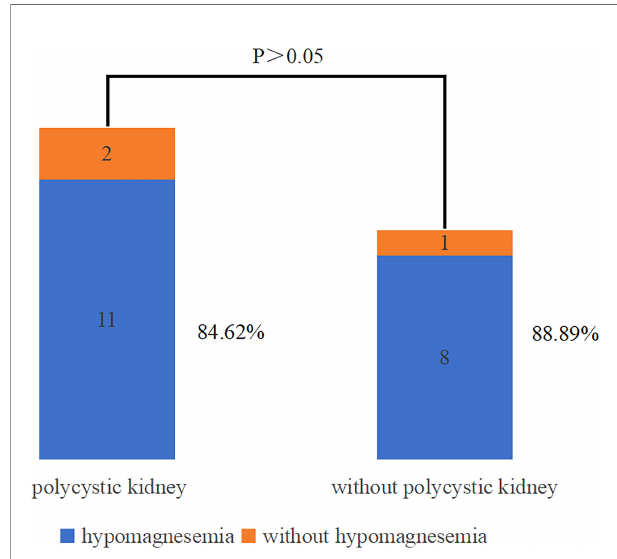
FIGURE 3 | Correlation analysis of hypomagnesemia and polycystic kidney disease in MODY5